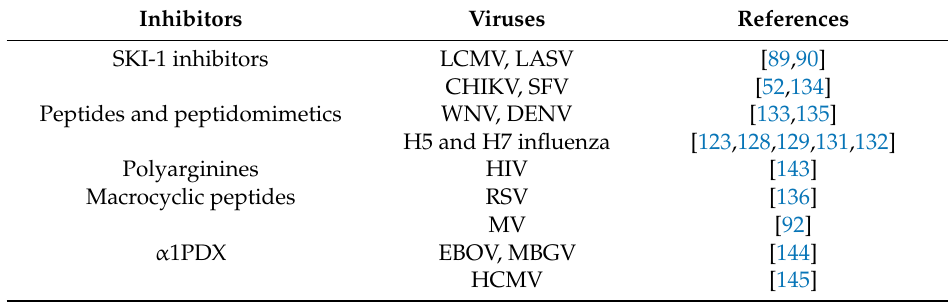
Table 6. Inhibitors of PCs tested for their antiviral activity in cell-based assays of viral propagation. Inhibitors